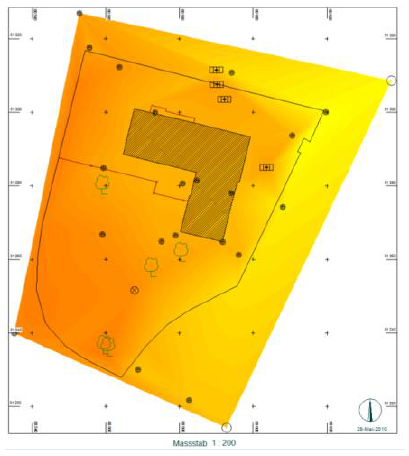
Figure 5. Resulting map in CAPLAN using tachymetry and GNSS information of the Campus Science City ETH